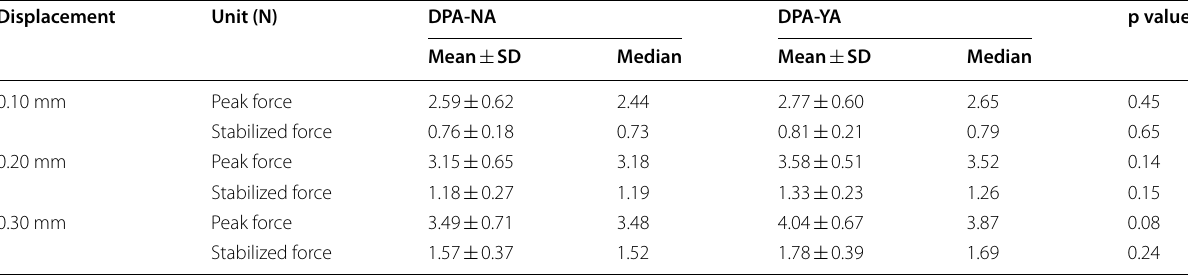
Table 2 Comparing DPA-NA (no attachments) and DPA-YA (with attachments)